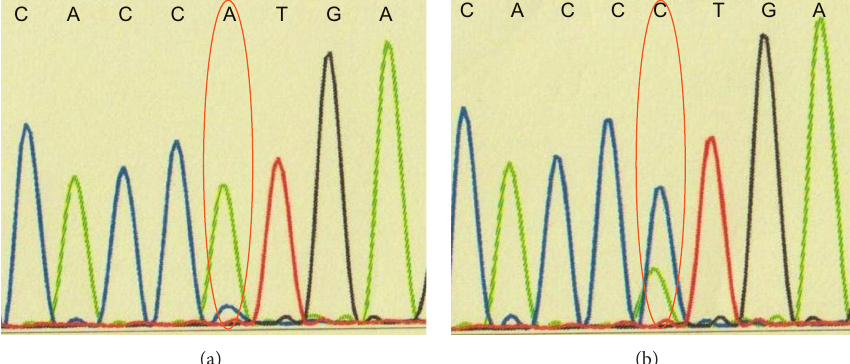
Figure 5: p53 gene sequences in exon 5–8 were analyzed. No alteration was identified in adenocarcinoma cells (a); in contrast, a transitional mutation (A to C) was identified in codon 179 of exon 5 in endocrine cells